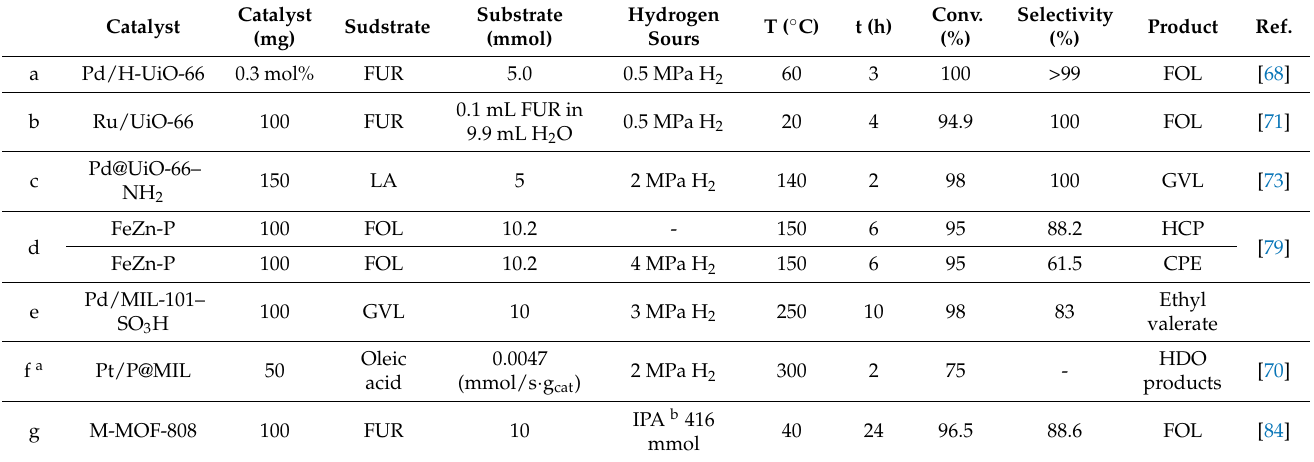
Table 3. Different catalysts and catalytic conditions in hydrogenation reactions for biomass